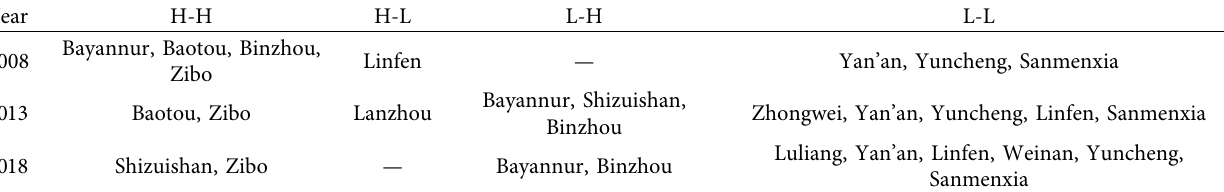
Table 4: Local LISA distribution of the UGDI in 2008, 2013, and